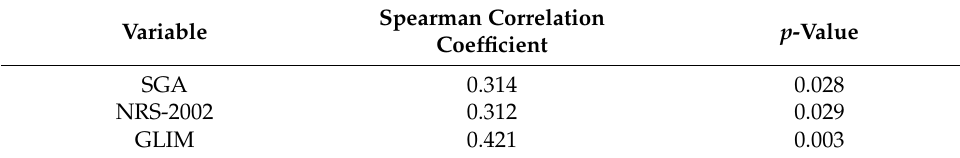
Table 4. Spearman correlation between PhA and nutritional status.